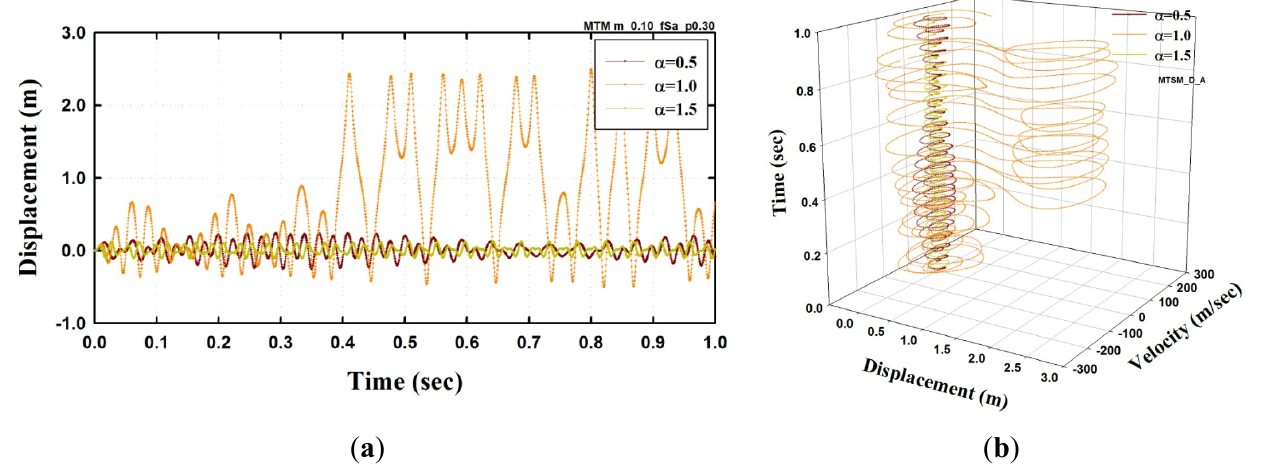
Figure 7. Dynamic analysis results of SFN model under a sinusoidal